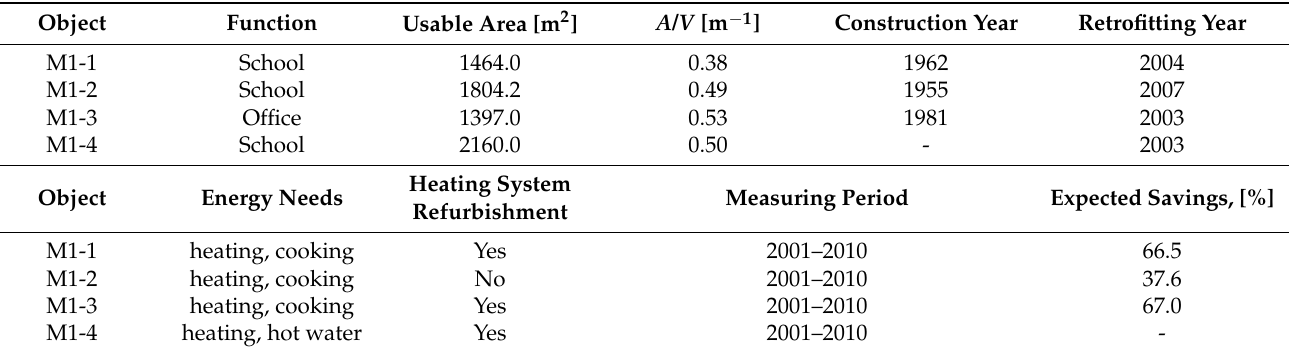
Table 1. Characteristic of buildings from group M1.